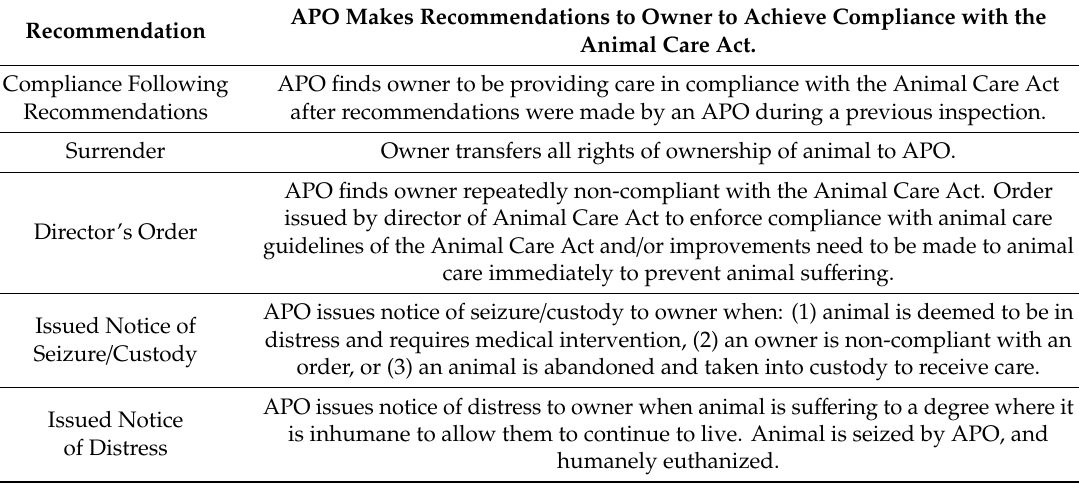
Table 5. Actions Taken by APOs if non-compliance with Animal Care